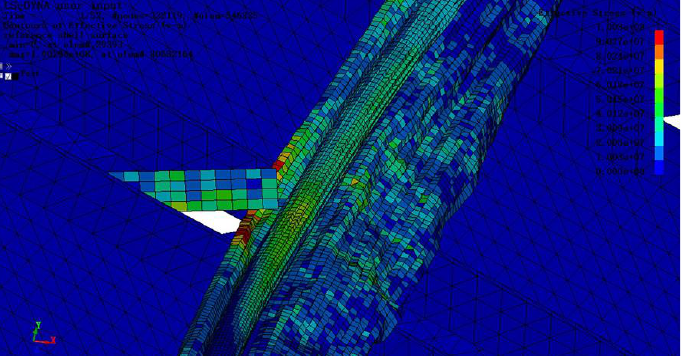
Figure 8. Situation in which the maximum Von Mises stress of the blade appears .